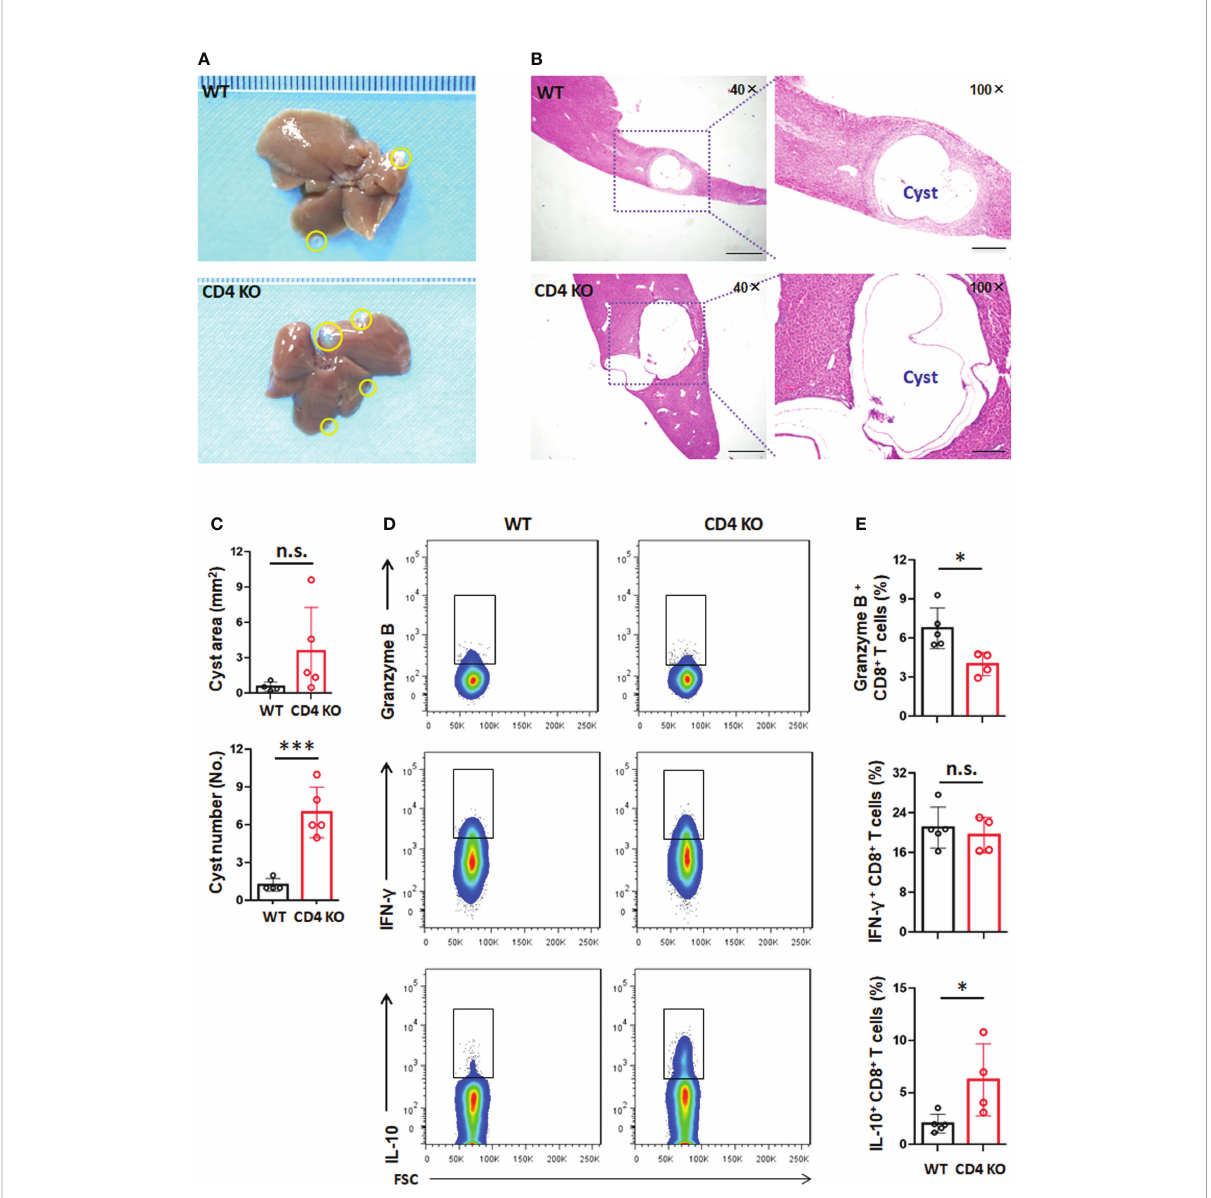
FIGURE 6 CD4 T-cell de fi ciency promotes PSC development into cysts in the liver in E granulosus s.s. -infected mice. (A) Representative image of livers of wild type (WT) or CD4 KO mice at week 10 post infection. The yellow line encircles metacestode tissues. (B) Representative hematoxylin and eosin (H&E) staining (left panel 40×, enlarged 100× on the right panel) of liver section from WT or CD4 KO mice at week 10 post infection. (C) Area (mm 2 ) and number of the infectious foci (hydatid cyst) in the liver of WT or CD4 KO mice at week 10 post infection. (D) Representative fl ow cytometric analysis for granzyme B, IFN- g and IL-10 production in CD8 + T cells in the liver from WT or CD4 KO mice at week 10 post infection. (E) The percentage of granzyme B, IFN- g and IL-10 production in CD8 + T cells in the liver, from (D) . 4-5 mice per group. Data are expressed as mean ± SD, analyzed by Student ’ s t tests. * P < 0.05, *** P < 0.001, no signi fi cance(n.s.) P >